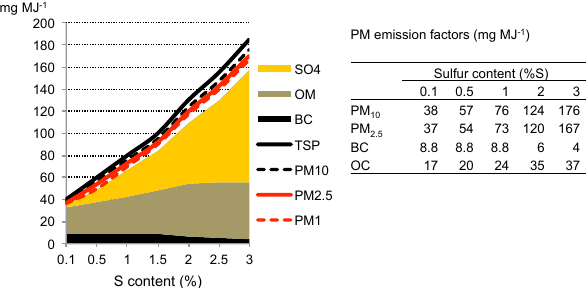
Figure 5. Particulate matter emission factors for shipping used in the GAINS